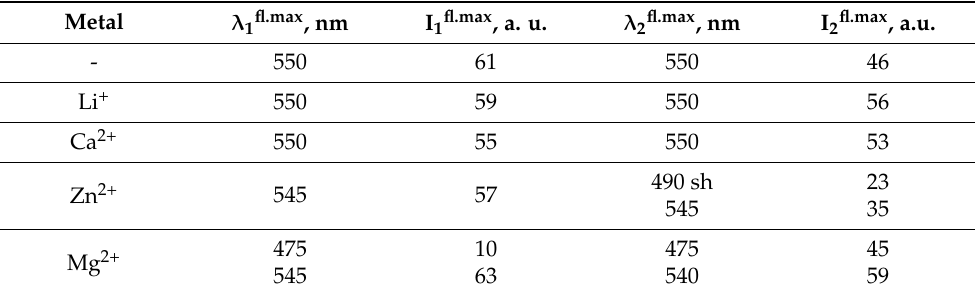
Table 3. Fluorescence characteristics of compound 1 and its complexes with metal ions in the toluene/acetonitrile solution at the ratio between molar concentrations between compound ( 1 ) and metal ion =